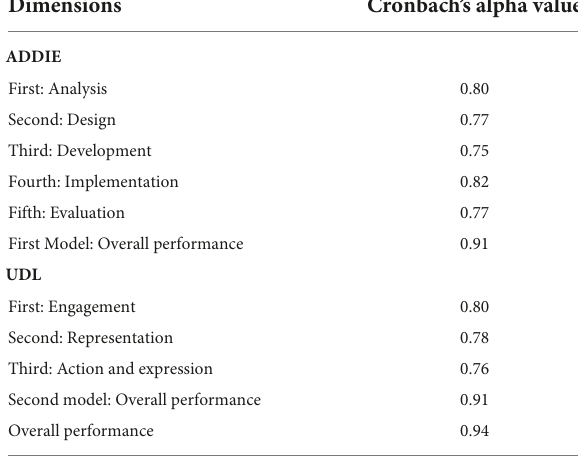
TABLE 1 Cronbachs’ alpha reliability analysis. TABLE 2 Descriptive statistics for